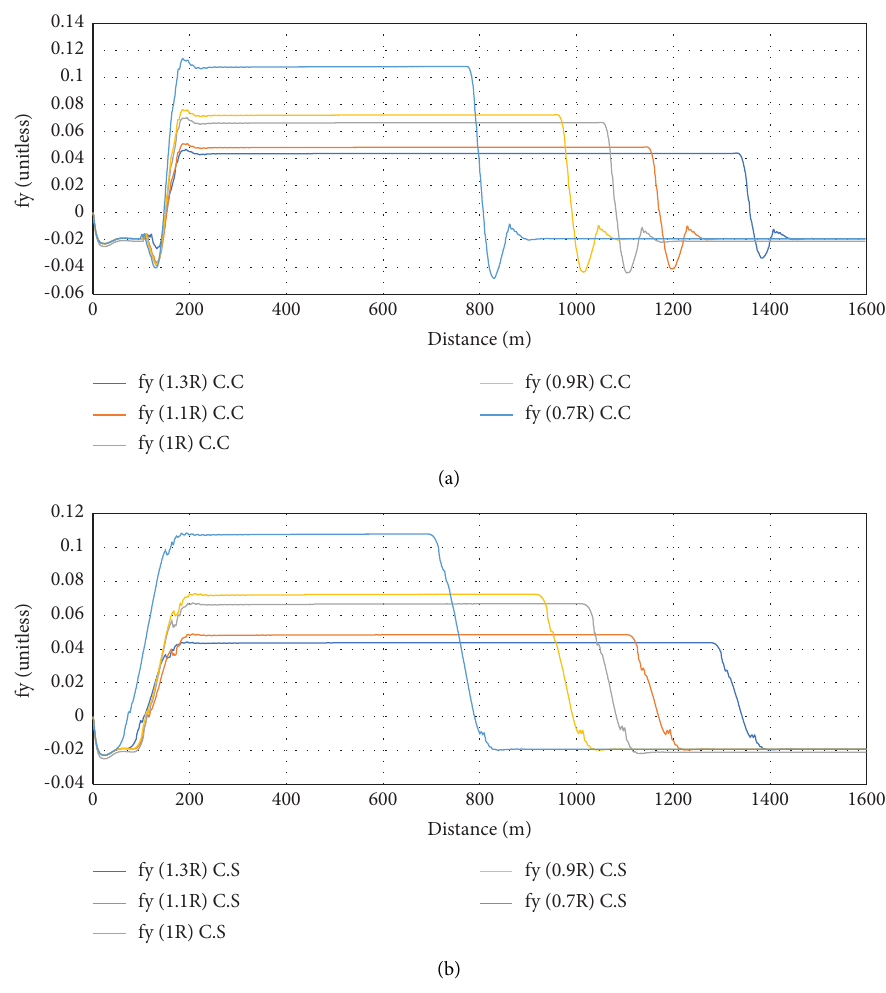
Figure 15: Comparison of side friction factors for the truck between diferent radii of horizontal curves: (a) simple and (b) spiral.